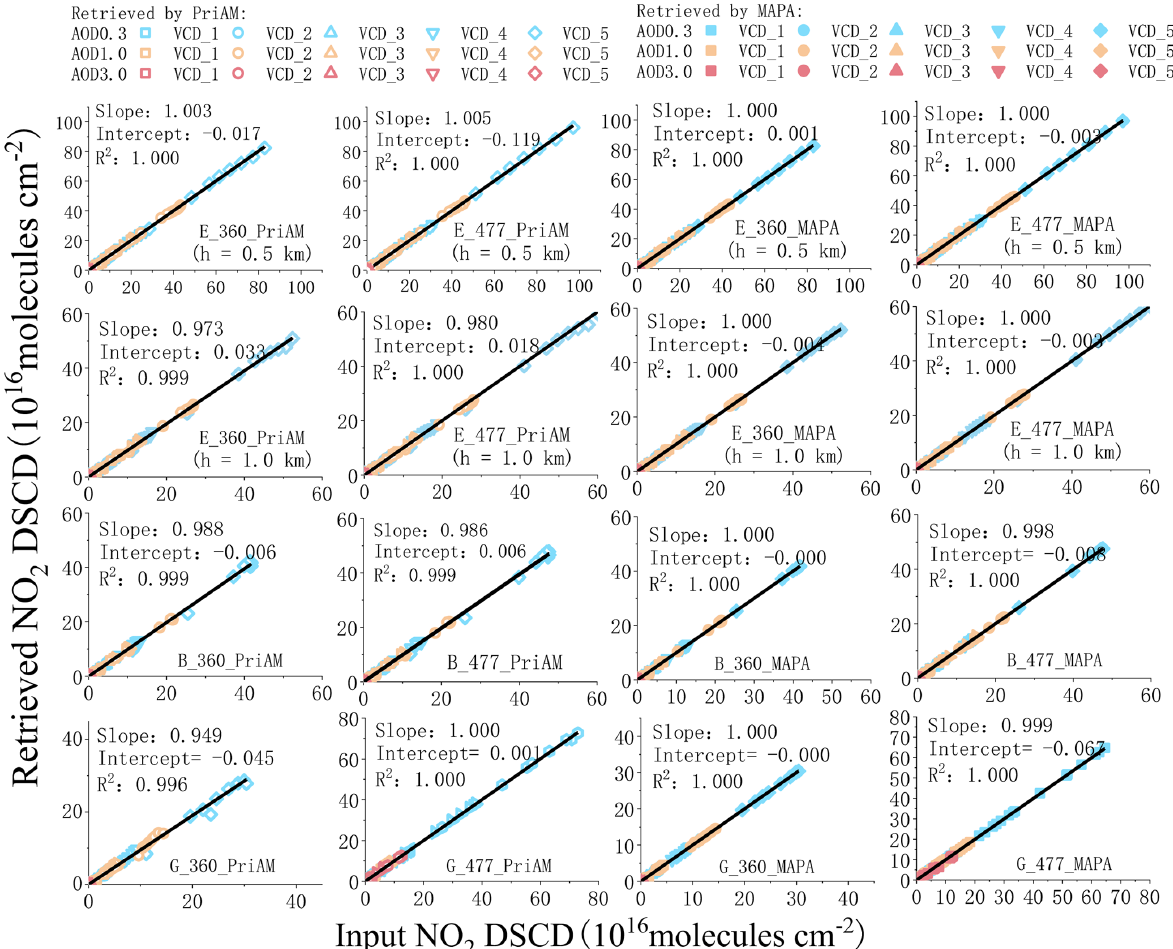
Figure 17. Correlation plots between the retrieved NO 2 DSCDs by PriAM and MAPA versus the input NO 2 DSCDs for three AOD scenarios and five VCDs for scenario S1. The colors refer to the VCD values and algorithms shown at the